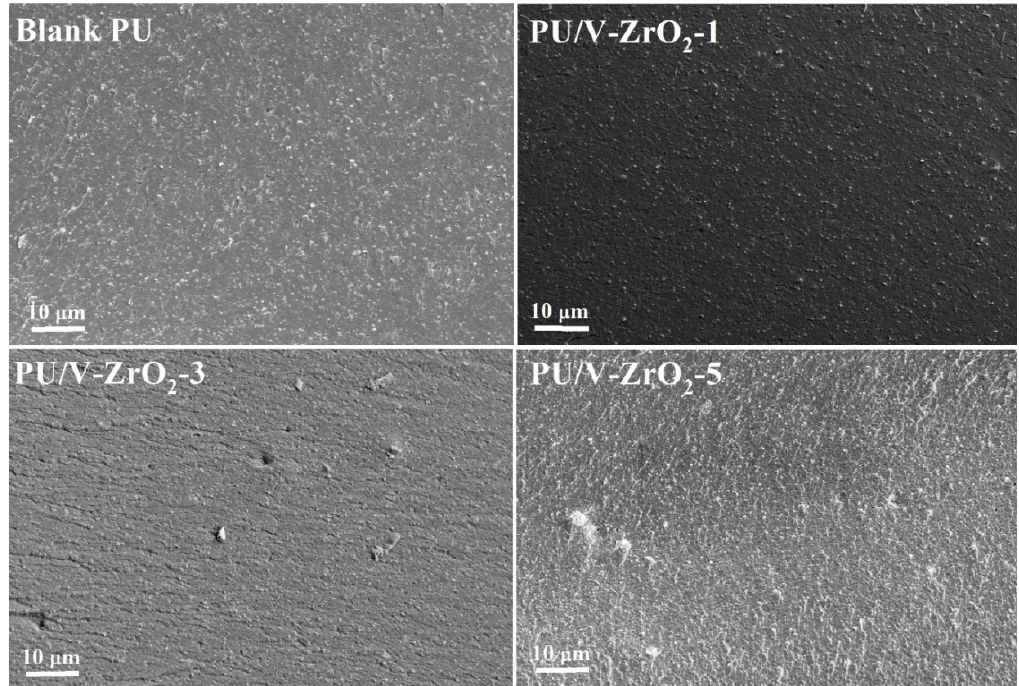
Figure 2. SEM micrographs of blank polyurethane (PU) and its nanocomposites containing 1, 3 and 5 wt.% of V-ZrO 2 , such that by increase of V-ZrO 2 content, from 0.1 to 0.3 wt.% and then 0.5 wt.%, some agglomerations of nanoparticles can be observed in the PU